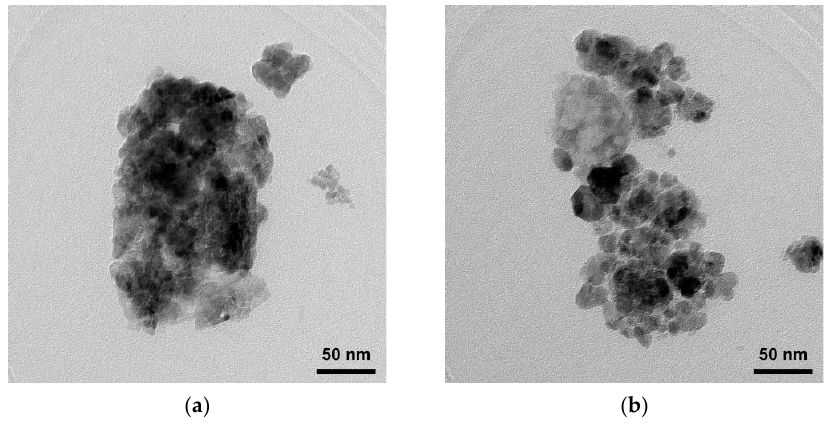
Figure 3. TEM images of ( a ) ZnO and ( b ) Ti-ZnO NPs.